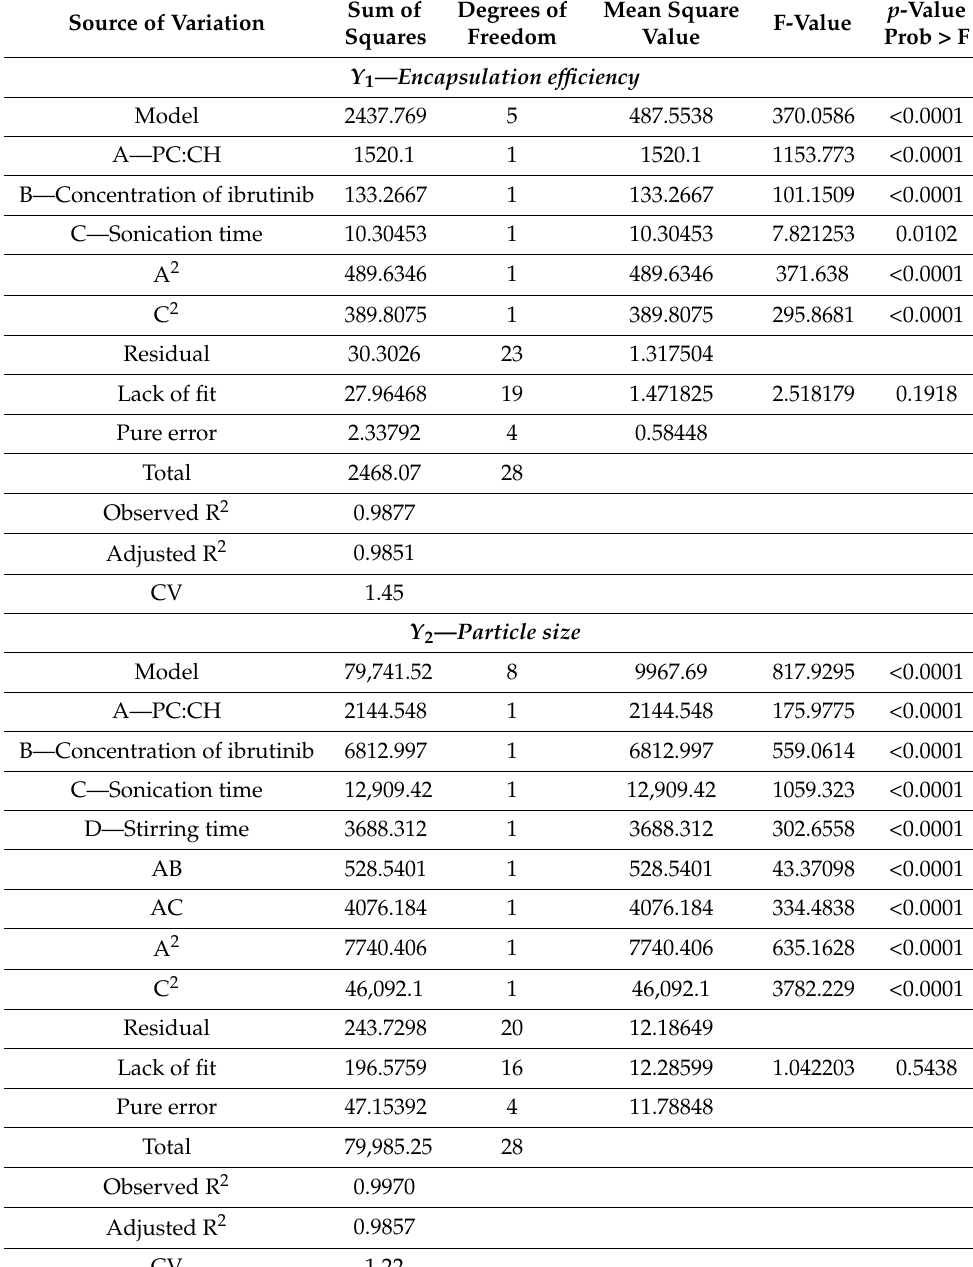
Table 3. Analysis of variance of both the quadratic